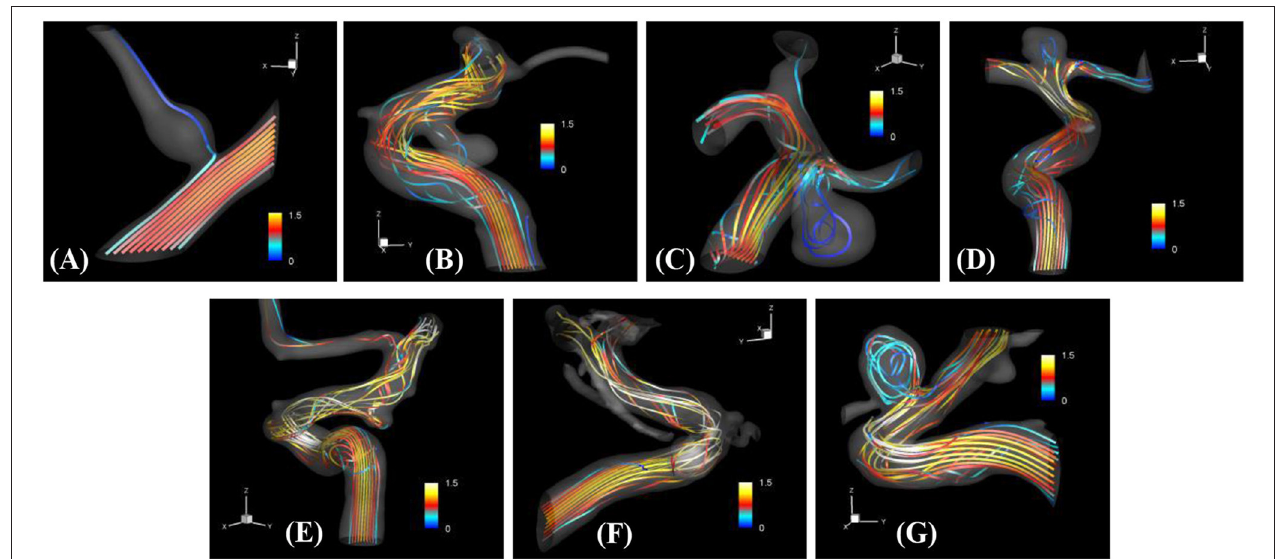
FIGURE 9 | The results of automated hemodynamic simulations using the present immersed boundary, level-set method for the sample cases (A–G) . Streamtraces colored by the normalized velocity magnitude, |E u | / U 0 . The color contours are truncated at the range shown in the color bar for the best visualization of local distributions.